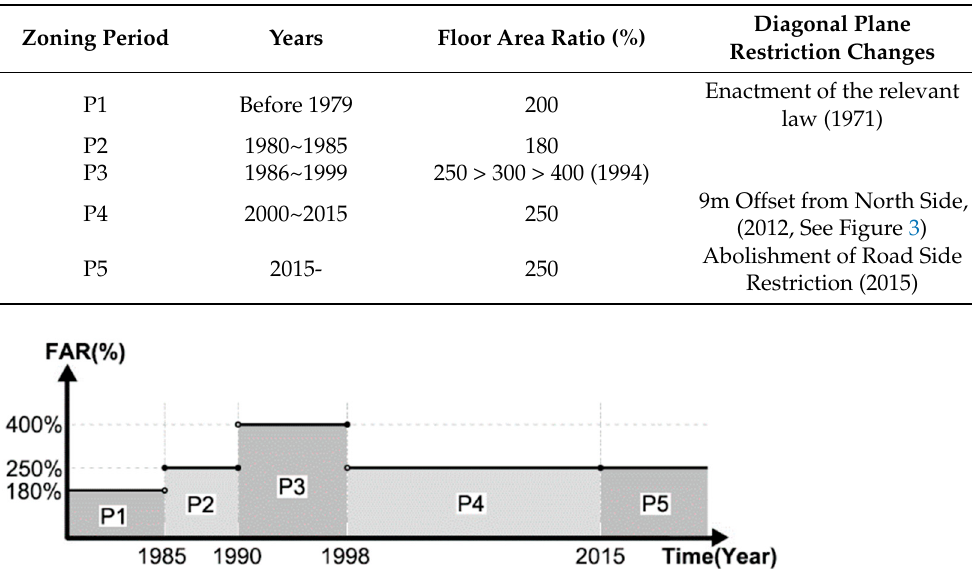
Table 8. Zoning period categorization.